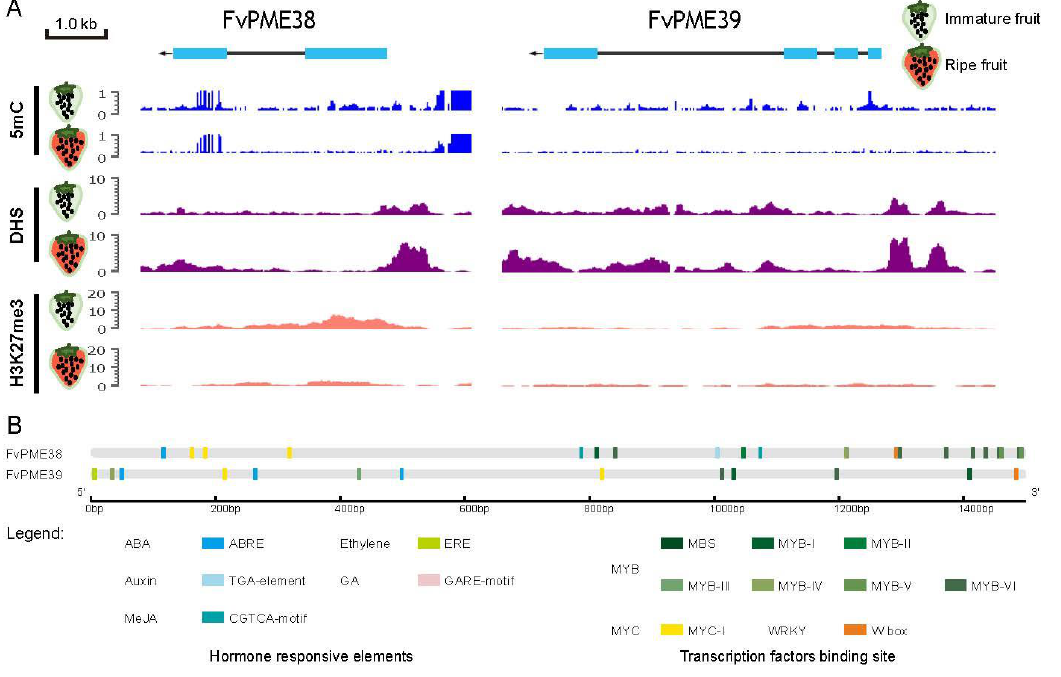
Figure 1. FvPME38 and FvPME39 genes are associated with tissue-specific epigenetic marks during strawberry fruit development. ( A ) DNA methylation, dynamic chromatin accessibility and histone modification of FvPME38 and FvPME39 genes in immature fruit and fully ripened strawberry fruit tissues. Individual data can be accessed on the fruitENCODE website. 5mC, 5 methylation cyanine; DHS, DNaseI hypersensitive sites; H3K27me3, H3 lysine-27 trimethylation; Green fruit, immature fruit; Red fruit, ripe fruit. ( B ) Putative cis-elements in the 1.5 kb promoter region of FvPME38 and FvPME39 genes.